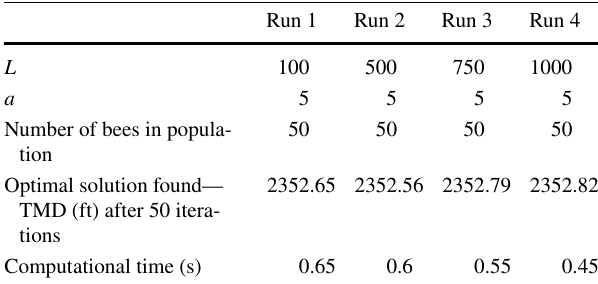
Table 5 ABC algorithm behavioral parameter variations and